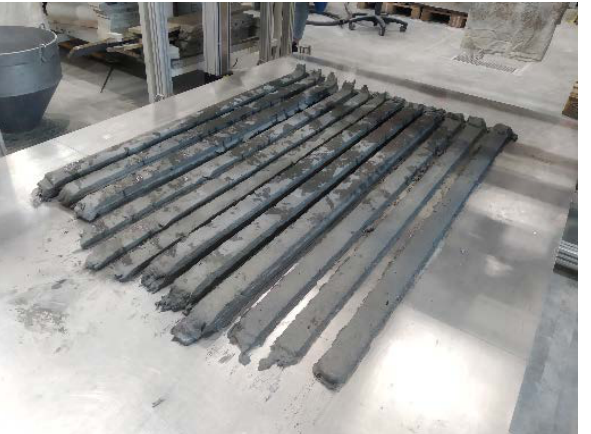
Figure 13. Filaments printed with SHCC mixtures Ref and SE-CE; photo was taken the day after printing and following removal of the cover foil.